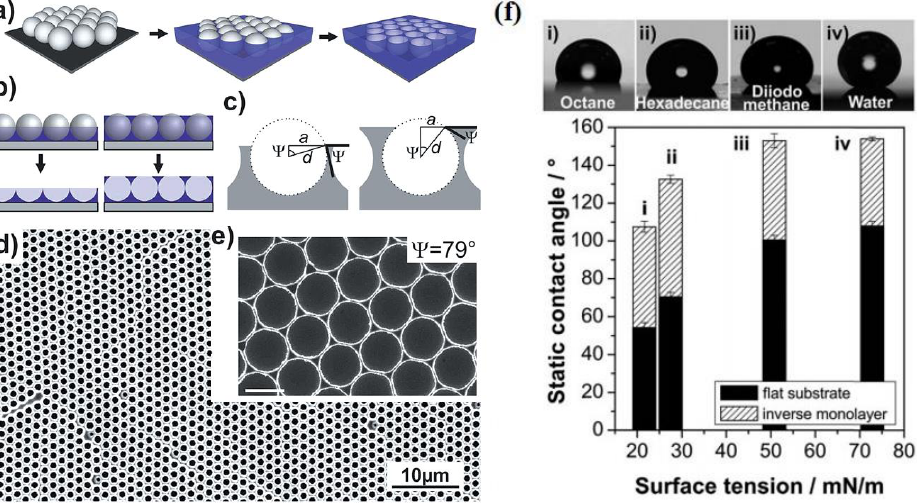
Figure 10. ( a ) Schematic illustration of the fabrication process of re-entrant structures from colloidal monolayer templates; ( b ) The precise controlling of pore opening by changing the content of SiO 2 precursor; ( c ) Geometric illustration of the relationship between the pore radius a , colloidal radius d , and the pore opening angle J for two exemplary pore openings; ( d ) SEM image of the prepared nanopore arrays and the corresponding inverse monolayer with pore openings of Ψ = 79°; and ( e ) Static contact angle of liquids with various surface tensions on inverse monolayers functionalized by fluorinated surface chemistry, scale bar is 1 μm. ( f ) The continuous increase in the contact angle with the change of liquid surface tension from 21.7 mN m −1 to 72.8 mN m −1 . (Adapted from [103] with